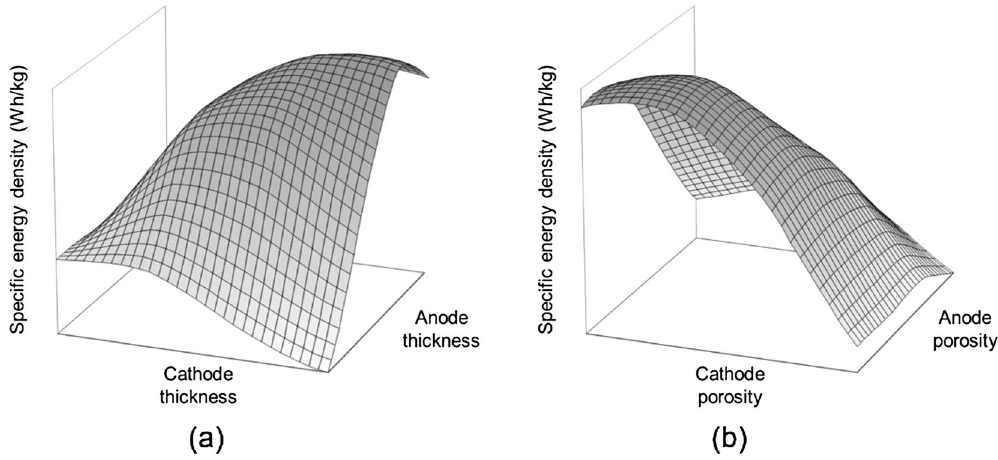
Figure 4. Specific energy density at sampling points of DOE for ( a ) electrode thickness ( b ) electrode porosity.